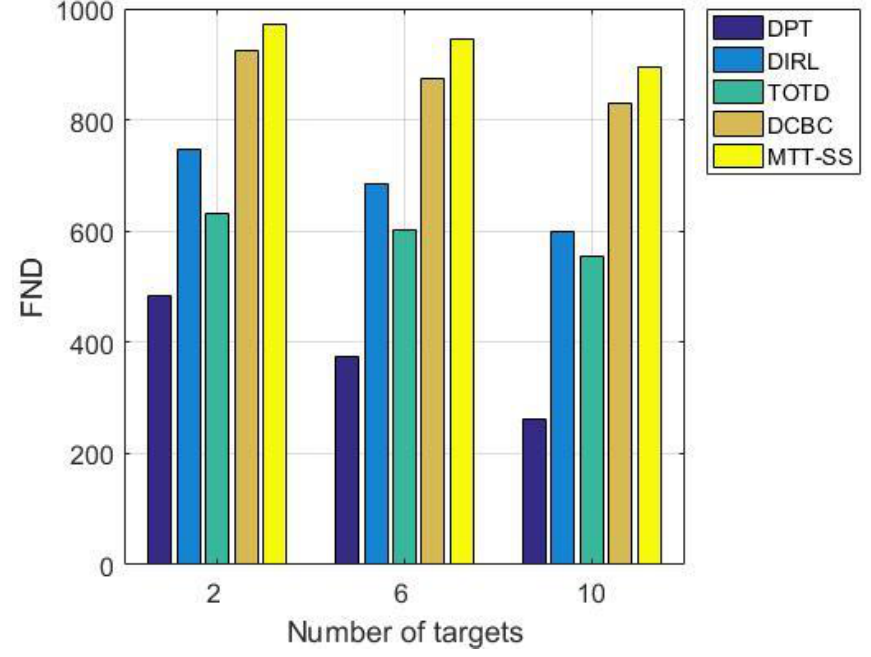
Figure 9. FND time steps vs. number of targets.